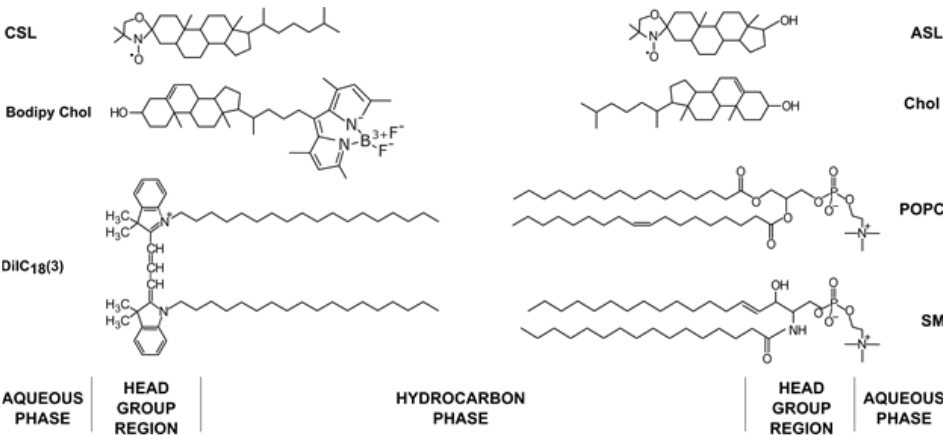
Figure 1. Chemical structures of lipids (1-palmitoyl-2-oleoyl-glycero-3-phosphocholine (POPC), SM and Chol), fluorescent dyes (Bodipy Chol and 1,1′ -dioctadecyl- 3,3,3′,3′ -tetramethylindocarbocyanine (DiIC 18 (3))) and spin labels (androstane spin label (ASL) and cholestane spin label (CSL)) used in the membrane model experiments with their approximate locations in the membrane bilayer. When the Chol content in the lipid bilayer exceeds a Chol saturation threshold